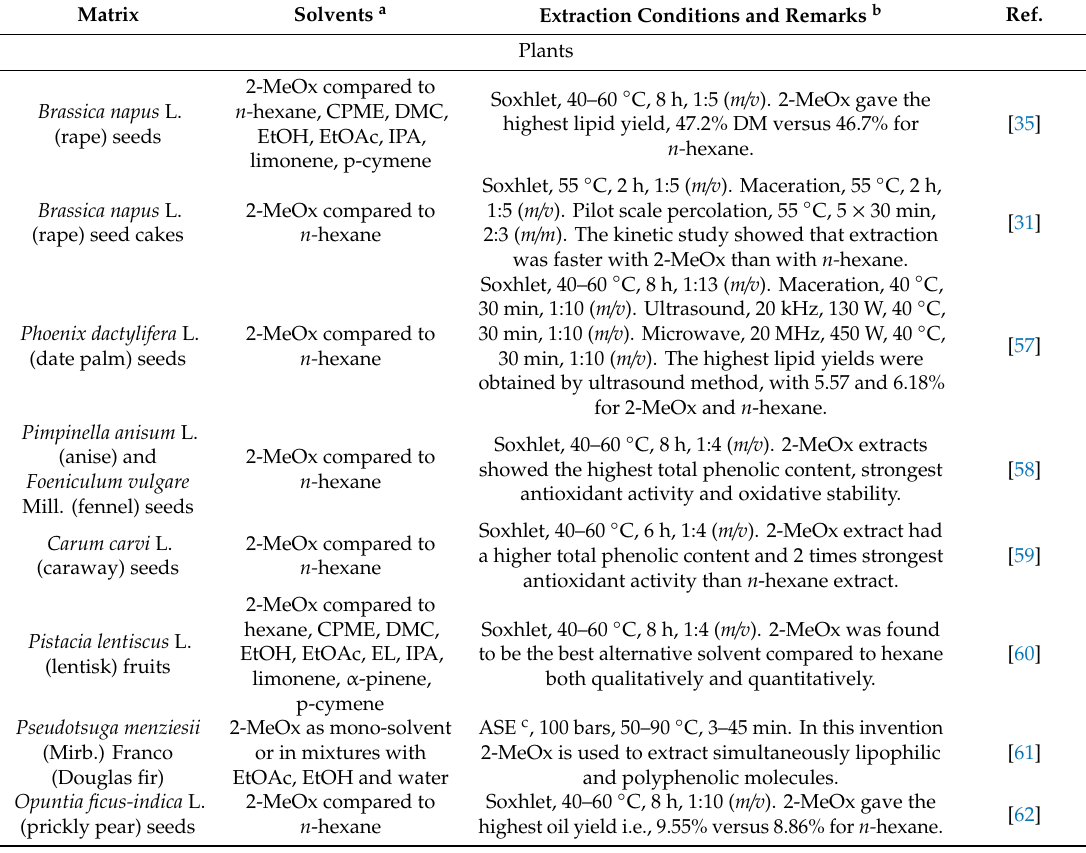
Figure 6. Representation of predicted solubilities of some lipids in n -hexane and 2-MeOx and their corresponding sigma surfaces, from [32,56]. TAG = Triglycerides, DAG = Diglycerides, FFA = Free fatty acid, ST1 = β -sitosterol, PC = Phosphatidylcholine. Rating: 0–20% bad solvent; 20–60% average solvent; 60–100% good solvent. Table 4. Lipid